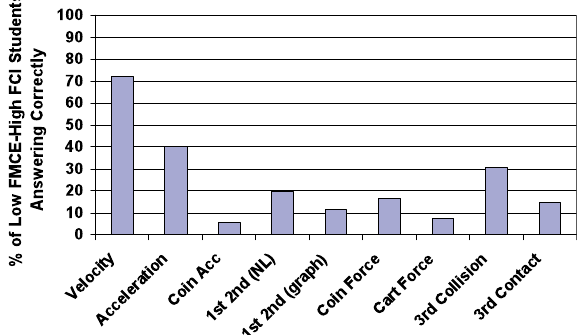
FIG. 6. (cid:1) Color online (cid:2) FMCE results grouped by conceptual category for students with 406 low on the FMCE (cid:1) (cid:2) 0.4 (cid:2) and high on the FCI (cid:1) (cid:4) 0.6 (cid:2) score pairs. Students are taken from both the pre- and postevaluations. NL stands for “natural language,” see Ref. 3 for more details.